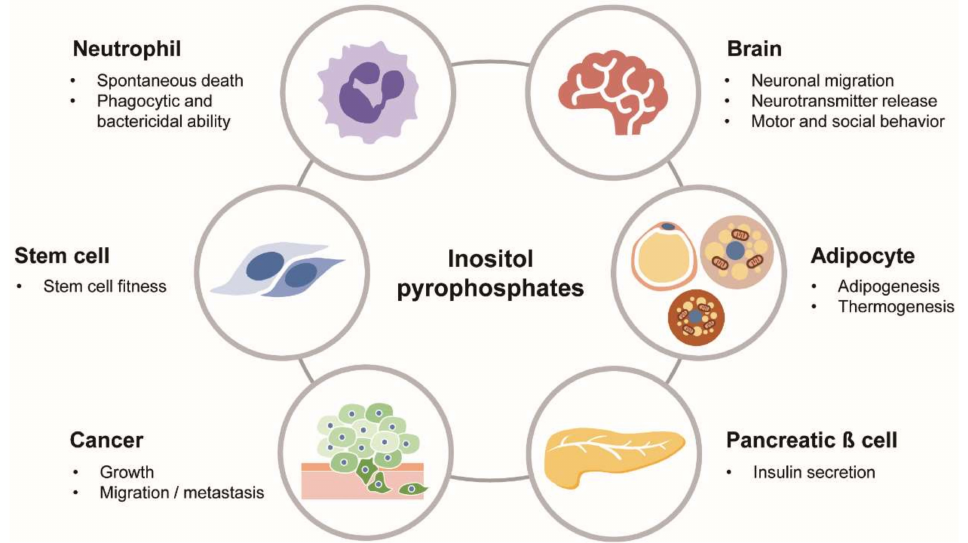
Figure 3. Biological roles of PP-IPs in physiology and diseases. PP-IPs as versatile signaling molecules play various biological actions in di ff erent cells / organs and pathological conditions, including